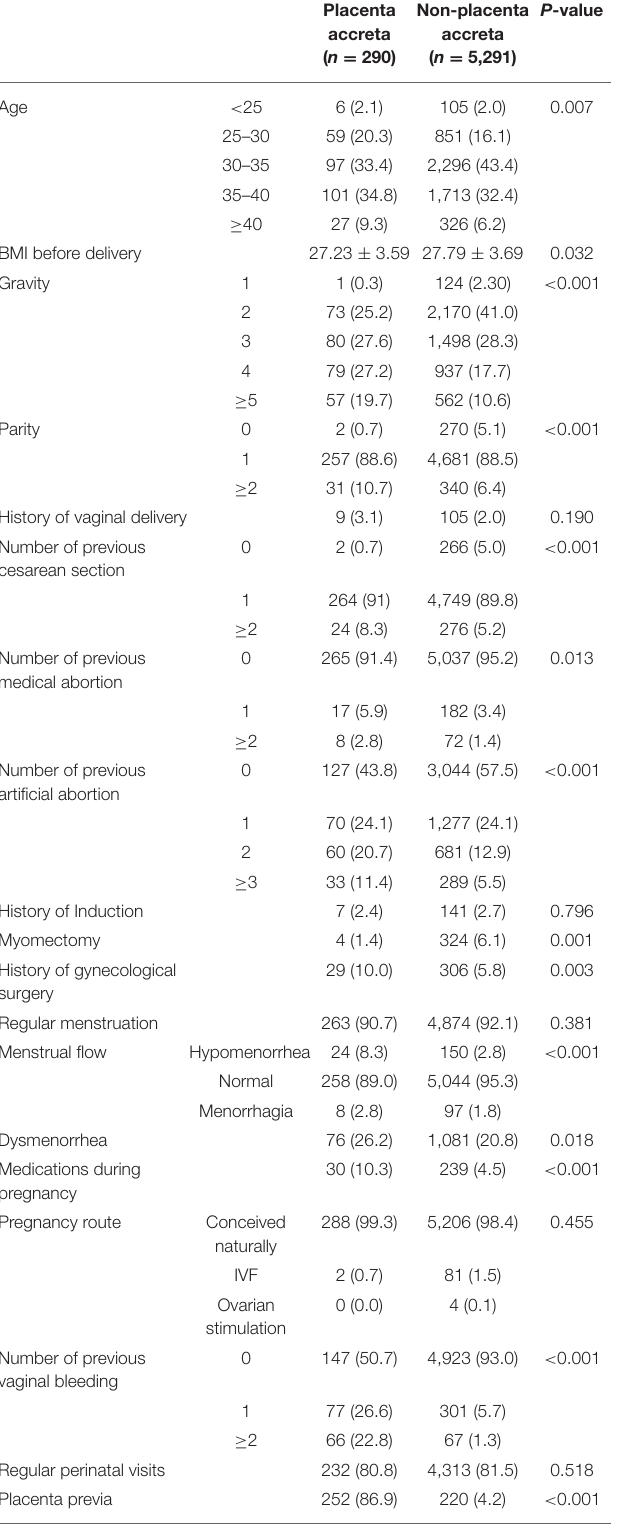
Placenta accreta